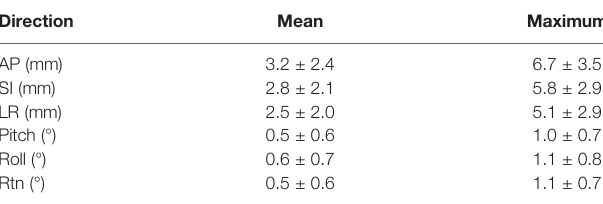
TABLE 3 | The initial setup errors analysis of 732 times of CBCT scan for 142 cases.